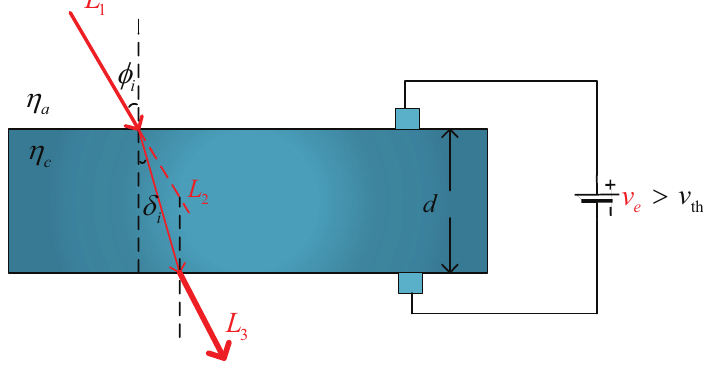
Figure 2. The detail of the propagation through the LC